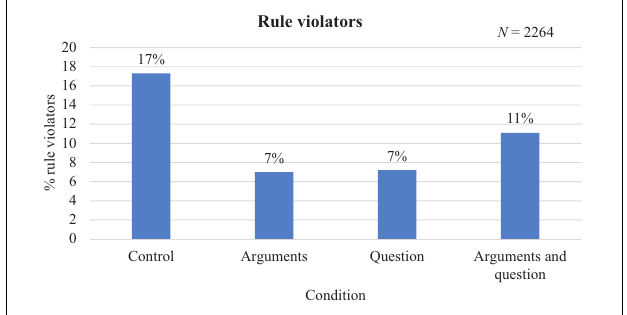
FIGURE 4 | Percentage of observed visitors that broke the non-luring rule per